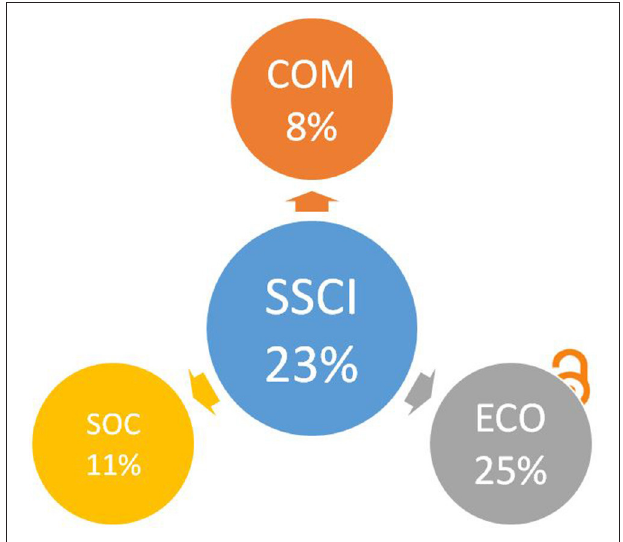
FIGURE 3 | Percentage of open access papers per discipline.